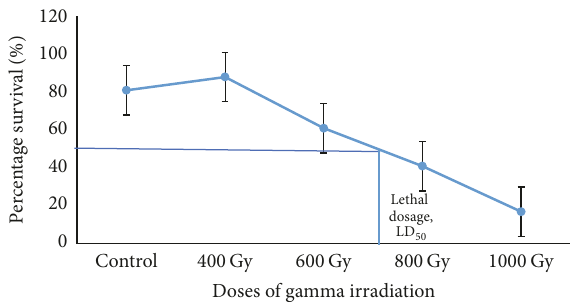
Figure 1: Percentage survival of okra seedlings in response to gamma